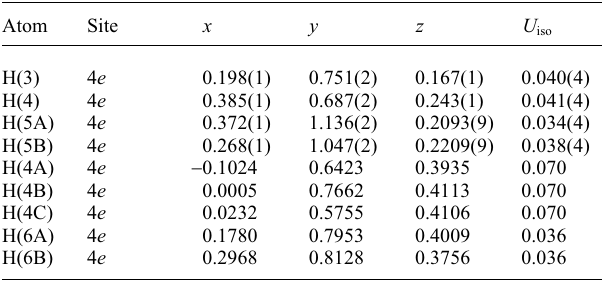
Table 2. Atomic coordinates and displacement parameters (in Å 2 )